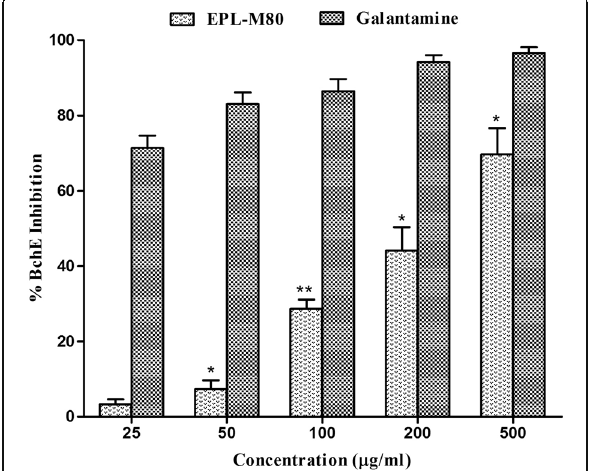
Fig. 2 Percentage of inhibition of butyrylcholinesterase at different concentration of EPL-M80 and the reference standard galantamine. Results are presented as mean ± SEM ( n = 3). * p < 0.05 and ** p < 0.01 denote significant difference compared to the